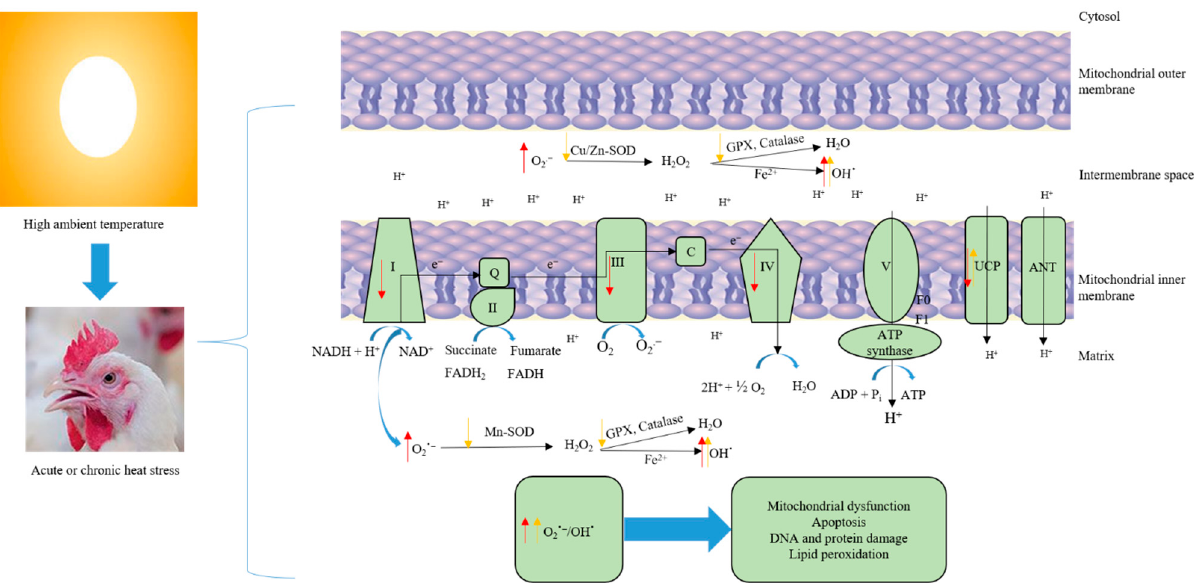
Figure 1. Heat load induces oxidative stress and mitochondrial dysfunction. Acute heat stress suppresses the activity of mitochondrial respiratory complexes I, III, and IV, downregulates uncoupling protein expression, and increases electron leakage, which in turn, leads to increased ROS production (Red arrows). Excessive ROS (O 2 − , OH) production causes dam- age to the protein, lipid, and DNA. Chronic heat stress, on the other hand, reduces the metabolic capacity of mitochondria via downregulating the activity and expression of antioxidant enzymes, and depleting the body’s antioxidant reserves, which causes accumulation of ROS—breaking the oxidative balance and inducing oxidative stress (yellow arrows).